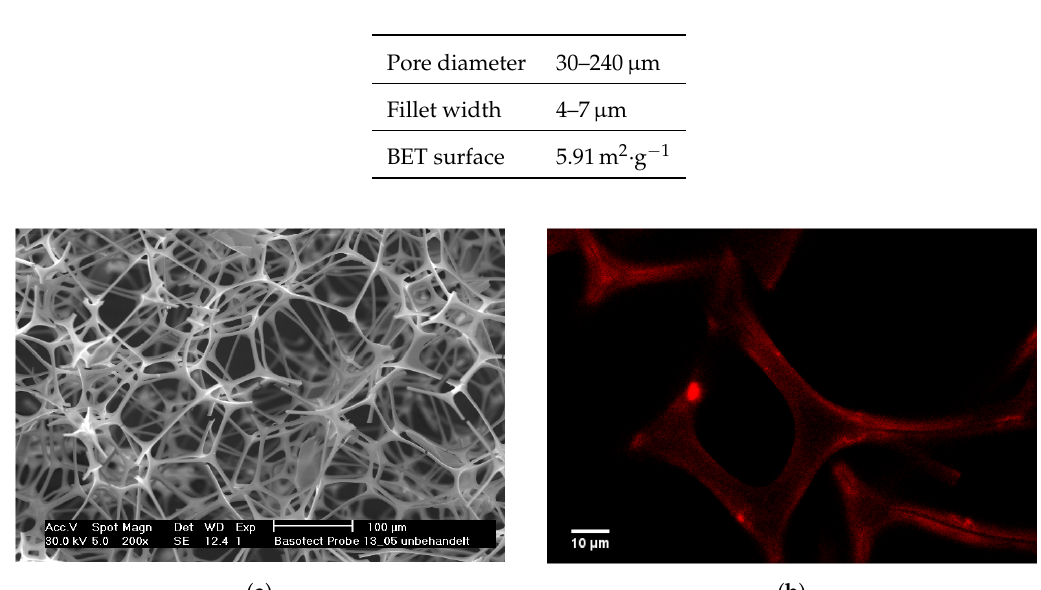
Table 1. Characteristics of Basotect ® .